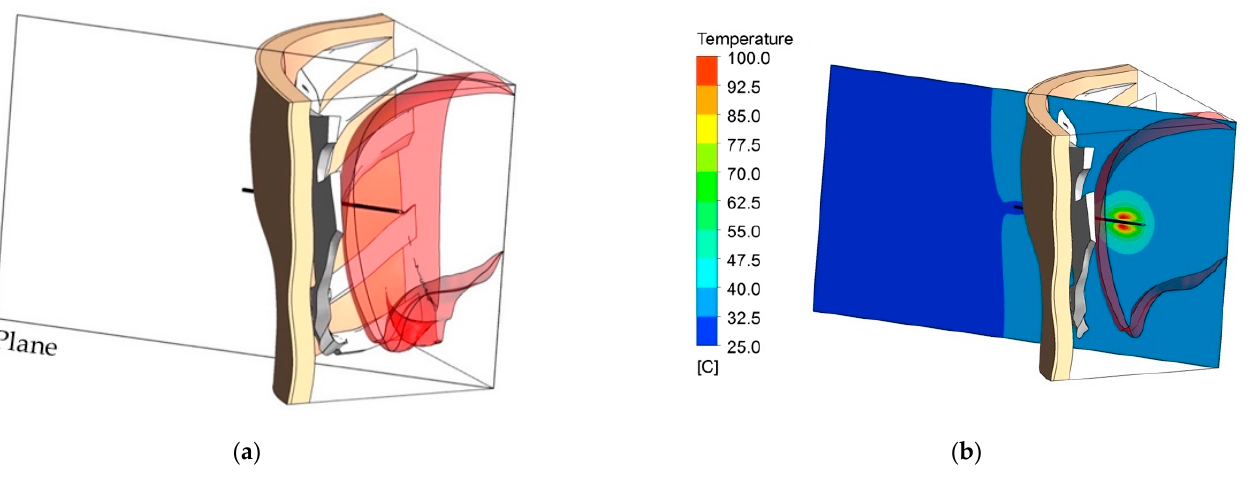
Figure 4. Illustration of the primary plane of interest that bisects the microwave probe in the axial direction. ( a ) Location of the primary plane, and ( b ) color contour diagram of temperature on the primary plane